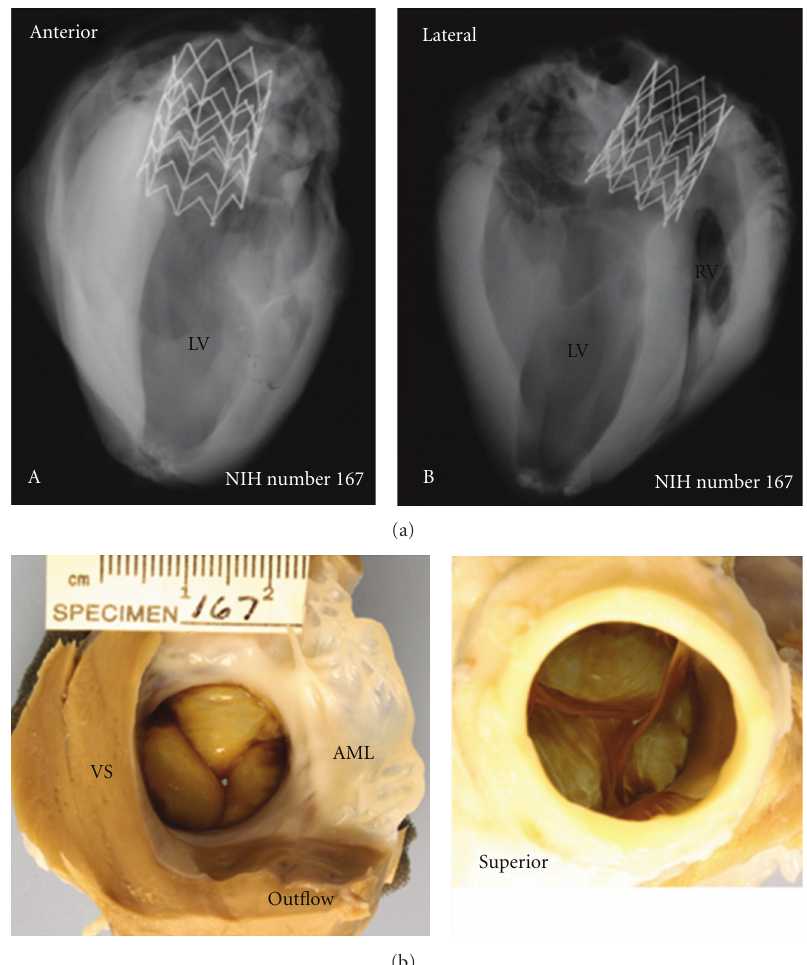
Figure 6: Radiographs (a) and necropsy results (b) of the hearts with the self-expanding prosthesis 6-months postimplantation. Both anterior and lateral views of the heart show an intact self-expanding stent frame without any fractures. The bottom row shows inferior and superior views of the self-expanding prosthetic aortic prosthesis; note that the entire stent frame crowns are covered as well as the annulus of the prosthetic valve is covered by opaque white tissue without pannus formation extending into the valve bases. The anterior mitral leaflet is unremarkable. The superior view of the aortic prosthetic valve shows good coaptation of the free edges of the valve leaflets. VS-ventricular septum, AML-anterior mitral